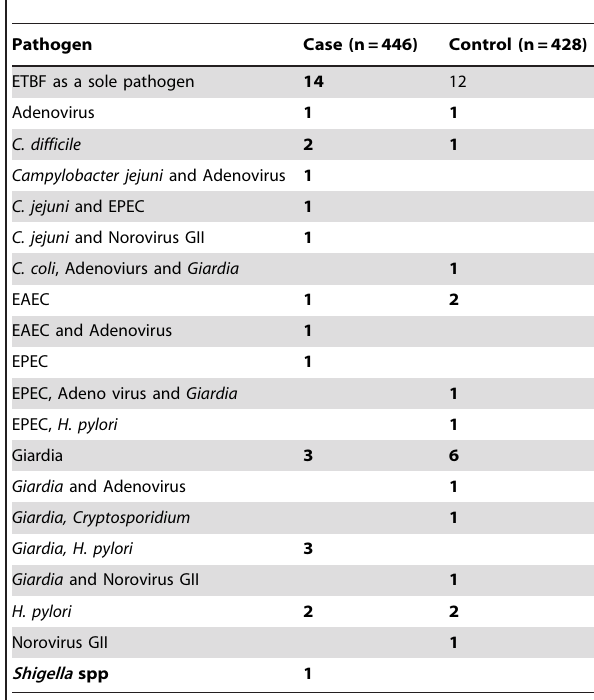
Table 2. Prevalence of ETBF as sole and with other pathogens in children with diarrhea and